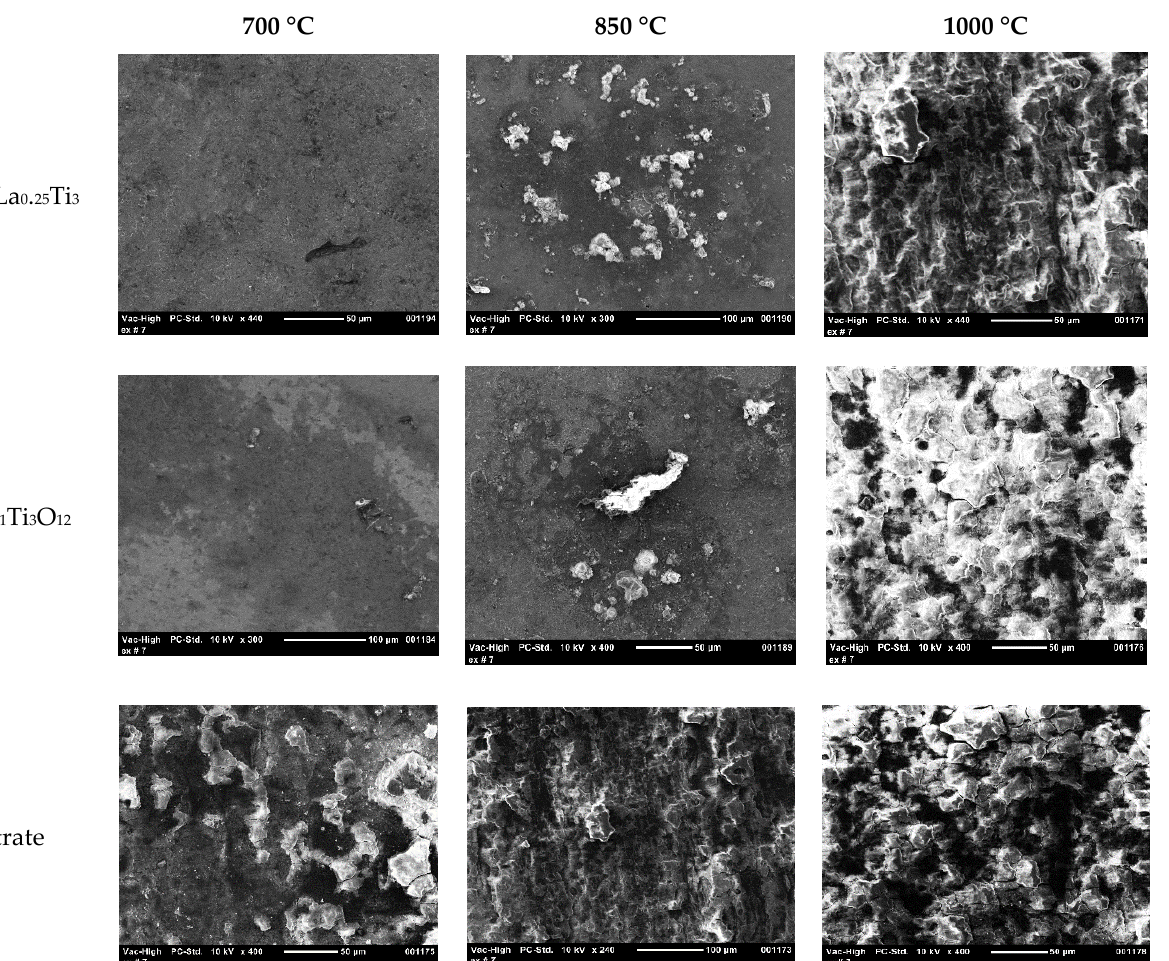
Figure 11. Micrographs via scanning electron microscopy for the Bi 3.75 La 0.25 Ti 3 O 12 and Bi 3 La 1 Ti 3 O 12 films.